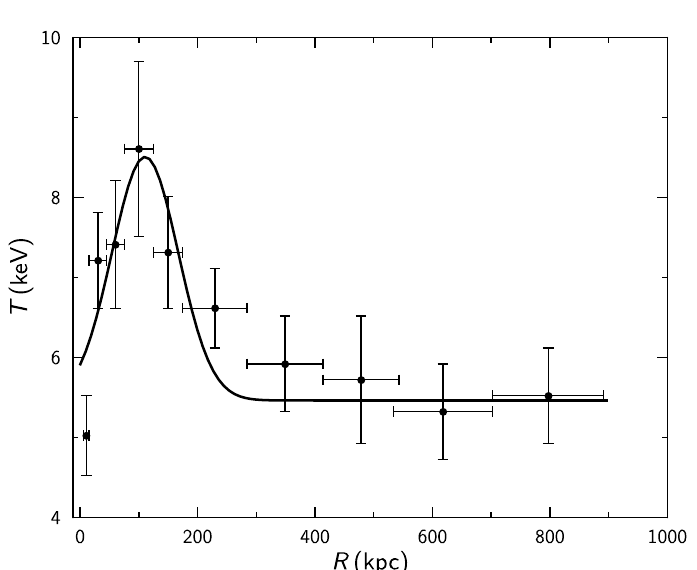
Fig. 1. The observed projected temperature pro(cid:12)le of CLJ1415 and the corresponding (cid:12)t from the DSDEPROJ